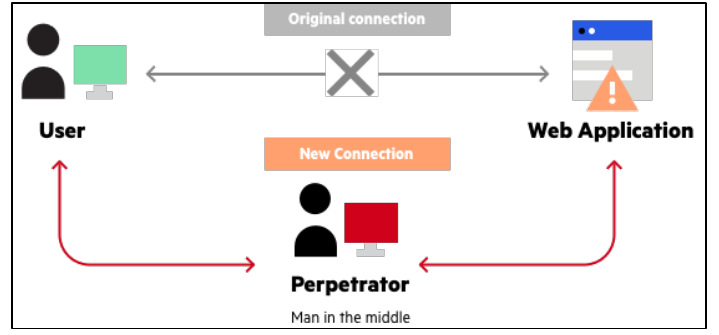
Figure 1. The Man-in-the-middle